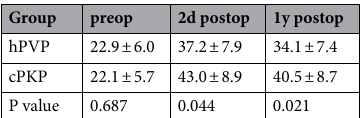
Table 4. The change of AVH (%) in the pre- and post-operative period.